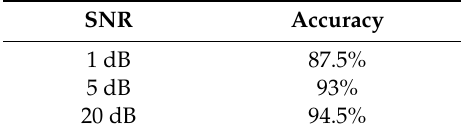
Table 4. The accuracy results for di ff erent Gaussian noise levels.